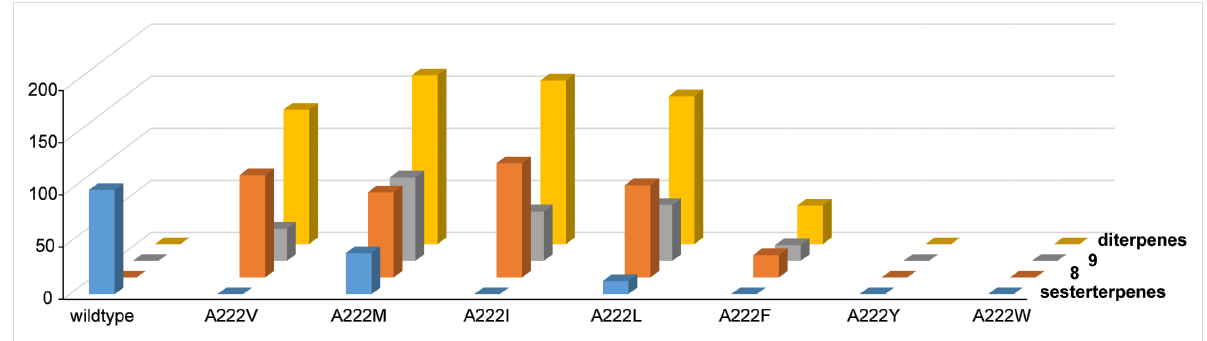
Figure 6: Relative activities of SmTS1 and its variants towards GFPP (blue bars) and GGPP (yellow bars), and the production of compounds 8 (red bars) and 9 (grey bars). Wildtype activity towards GFPP was set to 100%. Means from triplicates, for standard deviations cf. Table S3 and Figure S8.